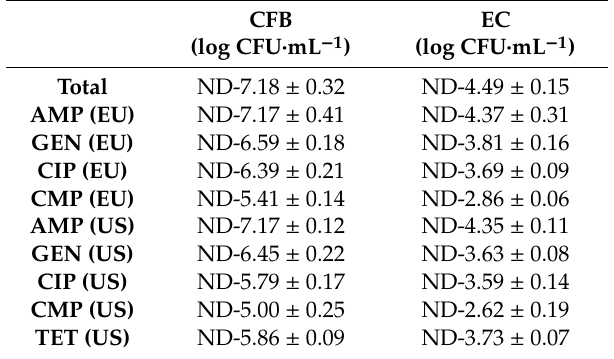
Table 3. Number of total and resistant coliform bacteria ( E. coli ) in hospital e ffl uents